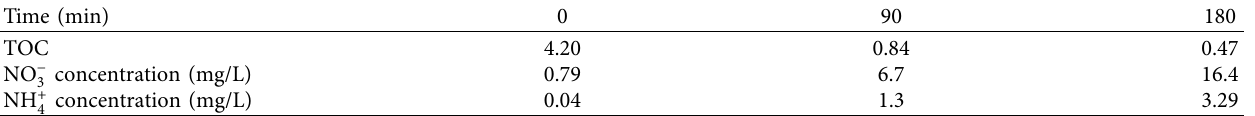
Table 2: TOC and ion measurements for degradation of trimethoprim using UV/ZnO process.